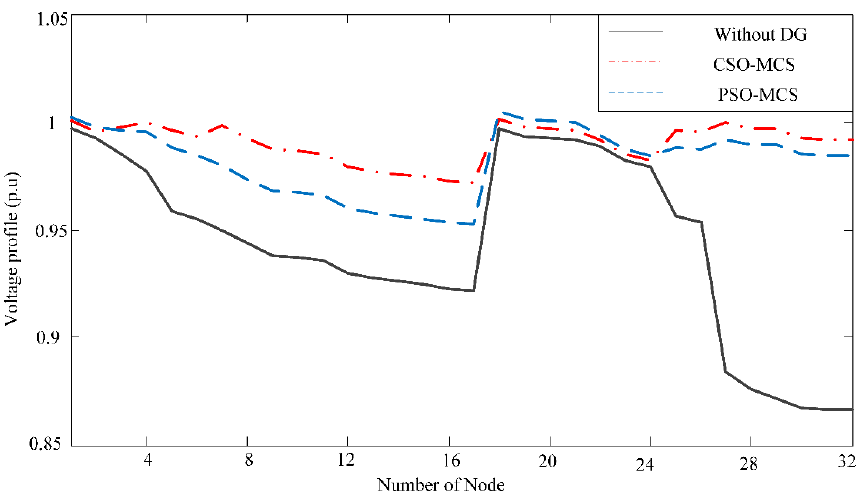
Figure 4. Voltage profile contrast (Case 1).